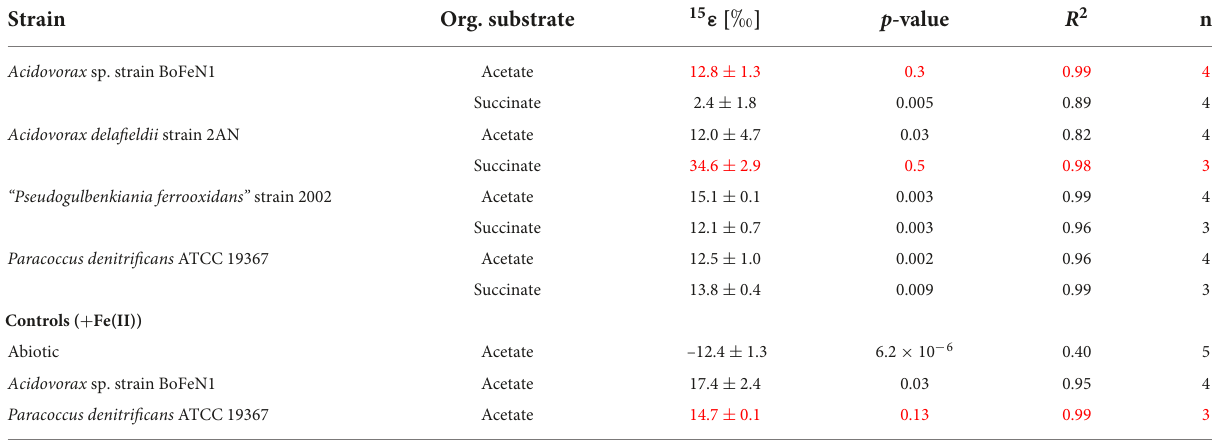
TABLE 4 Fractionation factors and p -values calculated for the different strains grown on NO 2 − and either acetate or succinate (i.e., without Fe(II)). Strain Org. substrate